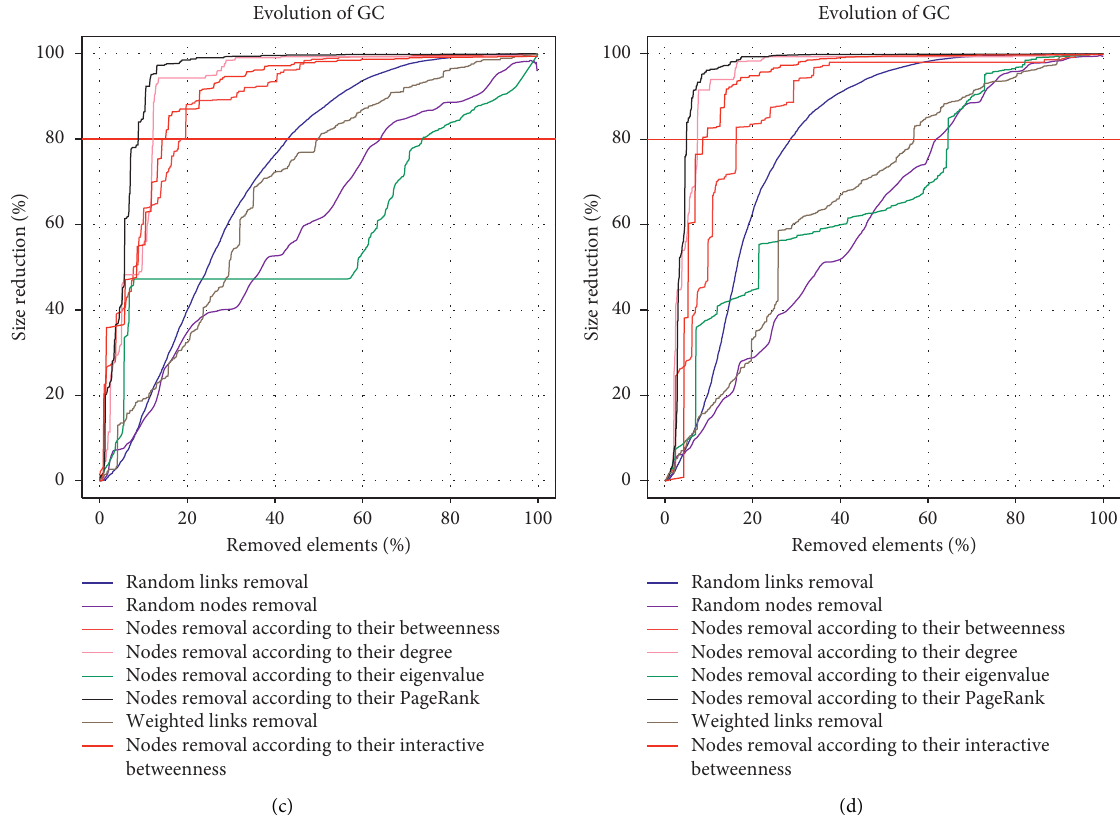
Figure 8: Evolution of the GC in EMT (a), BC Transit (b), Kolumbus (c), and Auckland (d) networks.